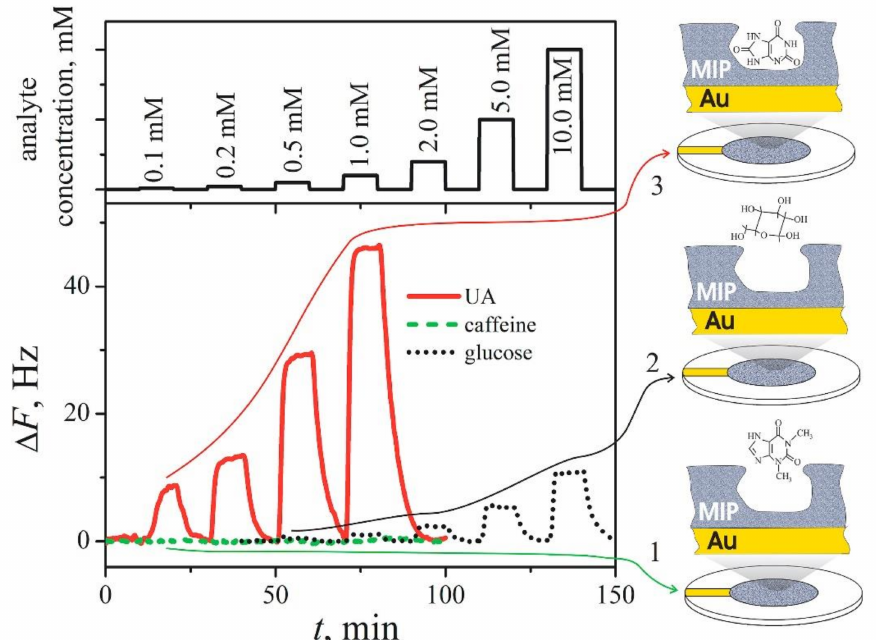
Figure 5. Variations of resonant frequency of an EQCM-resonator modified by uric acid-imprinted MIP(UA)-Ppy to the addition of different concentrations of uric acid (solid line 3), caffeine (dashed line 2) and glucose (dotted line 1) [96]. Copyright 2021 by Elsevier. Reprinted with